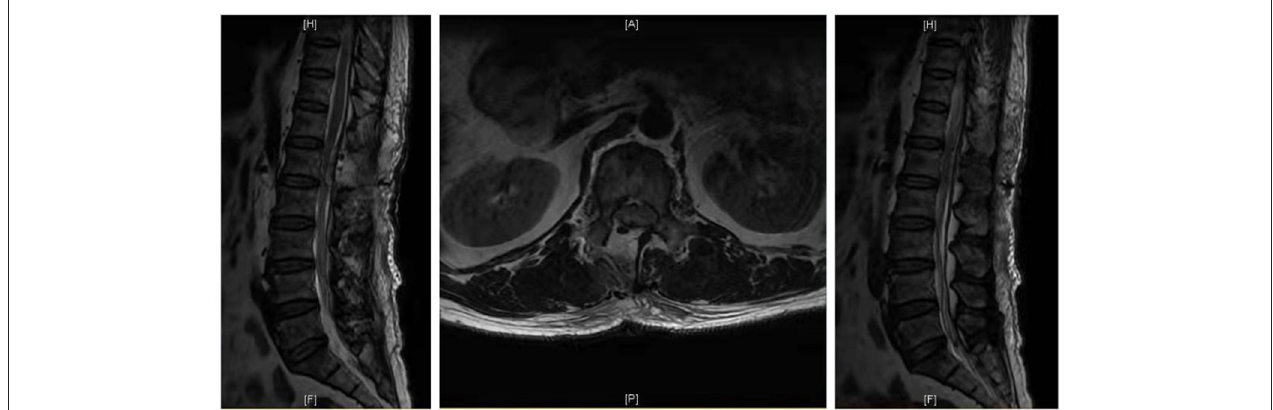
FIGURE 5 | Postoperative MRI of the case 1.